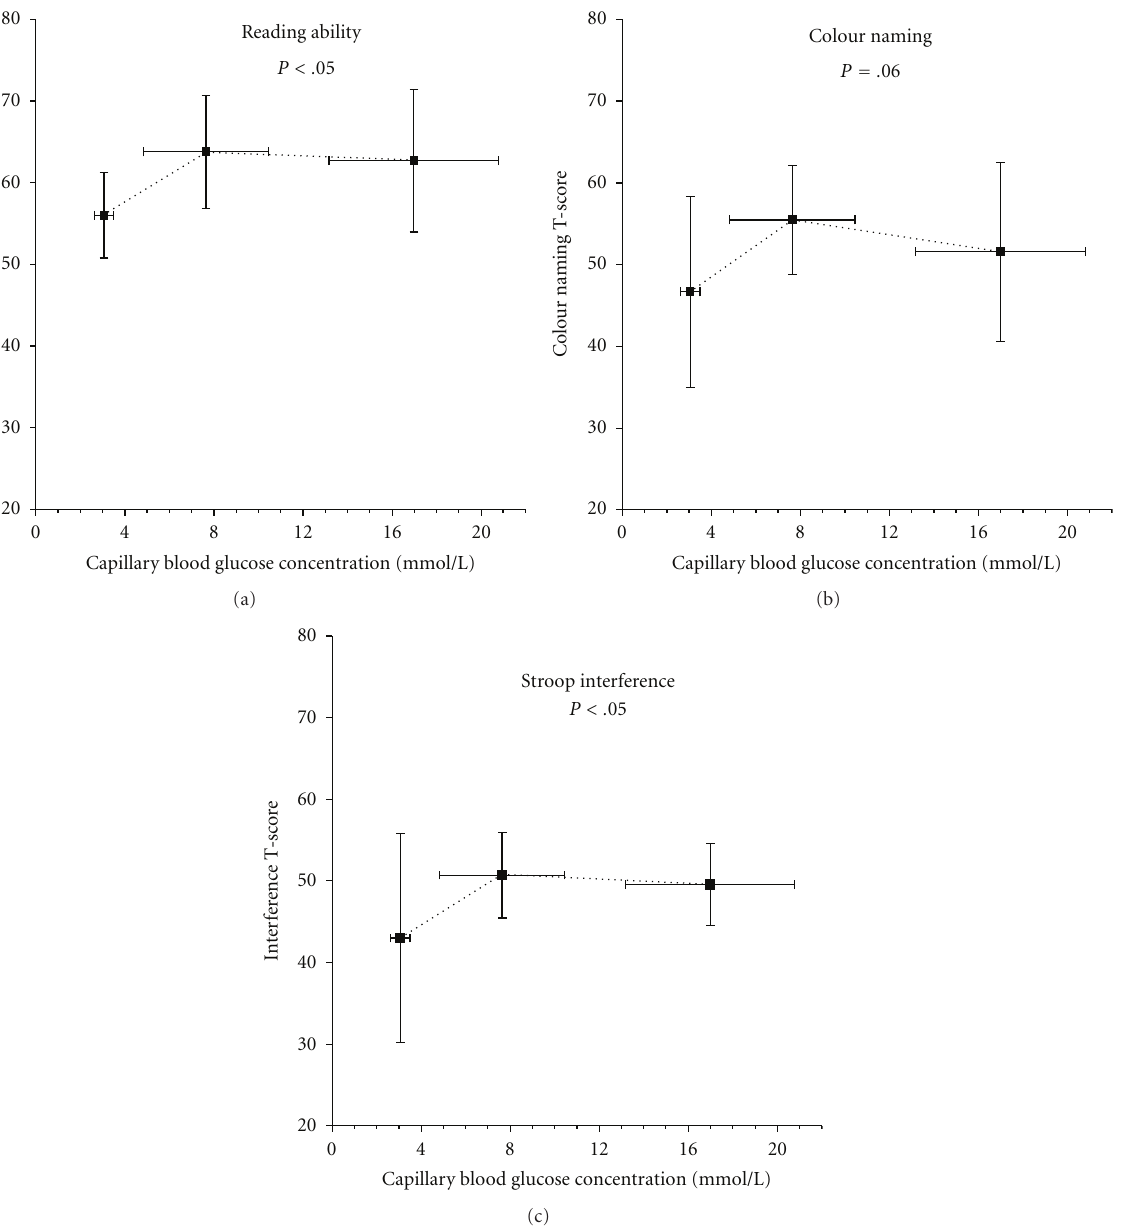
Figure 3: Stoop skill performance scores at each of the three categories of glycemia. Scores are shown as a percentage of personal best during the week. Scores during hypoglycemia were lower than euglycemia or hyperglycemia in reading ((a) P < . 05), color recognition ((b) P < . 05), and interference ((c) P = . 06). See methods section for a complete description. Mean ±